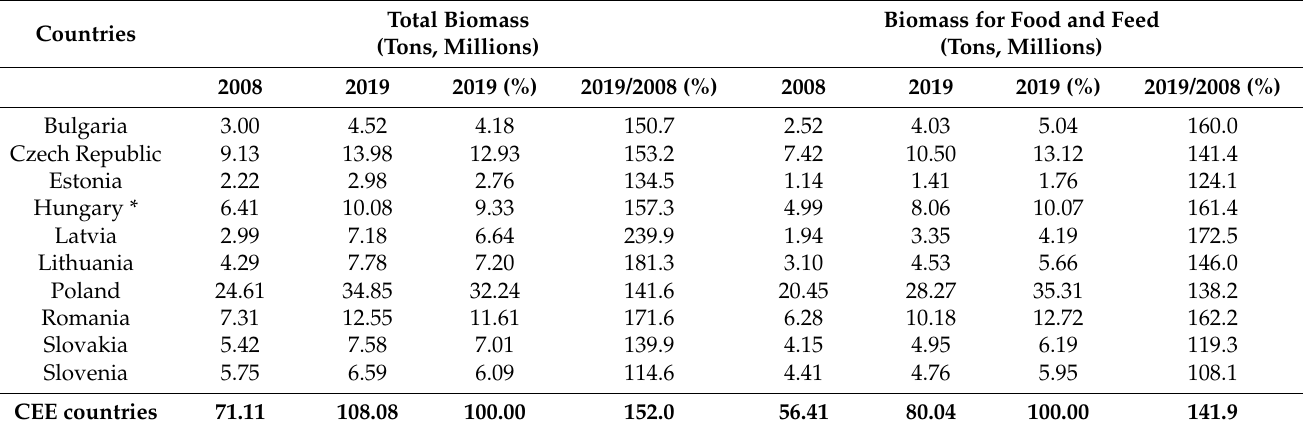
Figure 3. Share of domestic material consumption of biomass for food and feed in domestic material consumption of biomass (%) (based on OECD.Stat data [36], retrieved on 15 February 2022). On the trade side, the table below displays the imports of the biomass and biomass for food and feed, and the results obtained from the data investigation showed that in 2019, Poland kept first place among the 10 countries (32.24%), then, for the following two places, the situation changed, with the Czech Republic (12.93%) in the second place followed by Romania (11.61%) (see Table 9 below). In addition, the data show that the imports of biomass increased in the last decade in Latvia, Lithuania, and Romania, by over 70%, and the imports of biomass for food and feed by over 60% in Latvia, Romania, Bulgaria, and Hungary. Table 9. Import of biomass and biomass for food and feed.